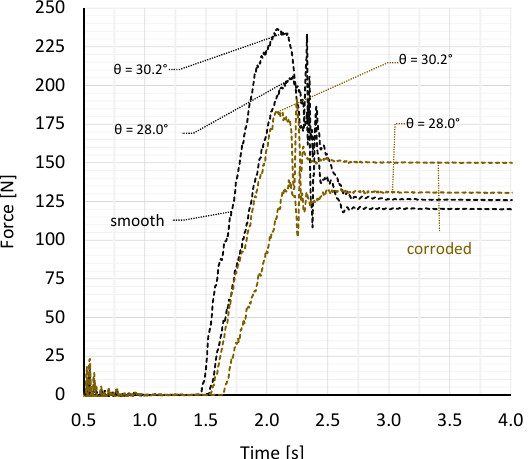
Figure 8. Comparison of the impact force–time history of the corroded and the smooth steel spheres for the inclinations of the flume base of 28° and 30.2°.